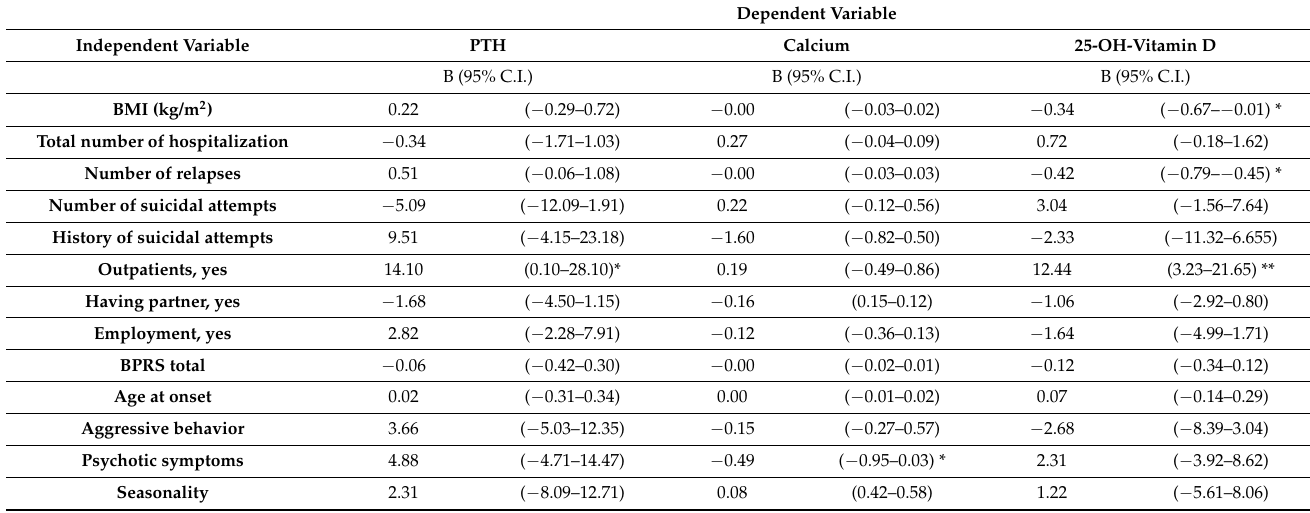
Table 3. Predictors of serum PTH, calcium, and 25-OH-vitamin D levels according to adjusted multinomial logistic regression